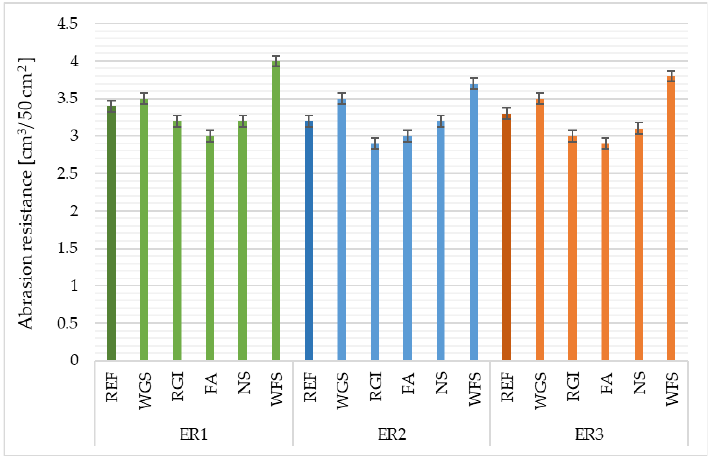
Figure 9. Abrasion resistance of epoxy composites depending on the type of filler and epoxy binder